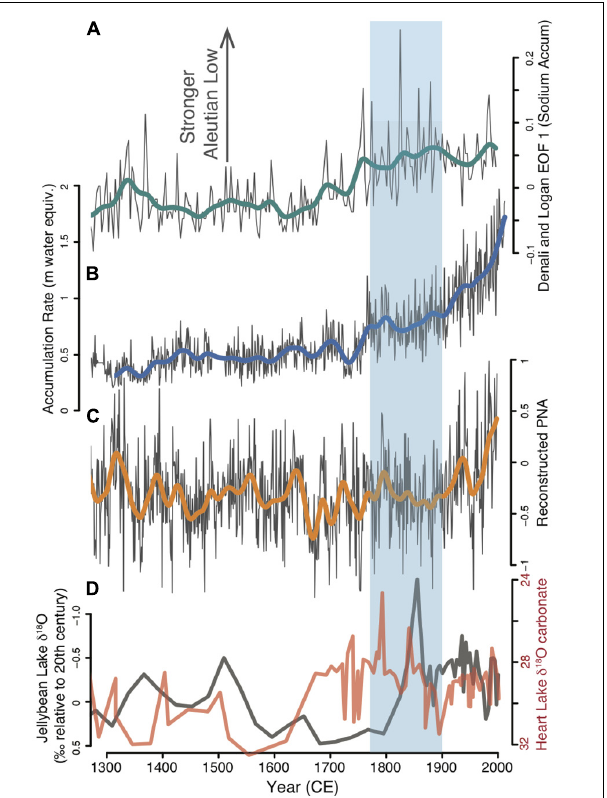
FIGURE 8 | Shifts or trends toward a stronger Aleutian Low pressure system preceded the 19th century glacier advance in Coastal Alaska (blue box). (A) Composite sodium record in ice cores from Mt. Logan (Yukon Territory) and Denali (Alaska) (Osterberg et al., 2017). (B) Accumulation rate of snow on Mount Hunter in the Alaska Range (Winski et al., 2017). (C) Reconstructed Pacific North American atmospheric circulation pattern based on tree rings and varved lake sediments from downwind North America, where more positive values coincide with a stronger Aleutian Low (Liu et al., 2017). (D) Oxygen isotopes of carbonate deposited in Jellybean Lake in the Yukon Territory (Anderson et al., 2005). Up in these graphs reflect a stronger Aleutian